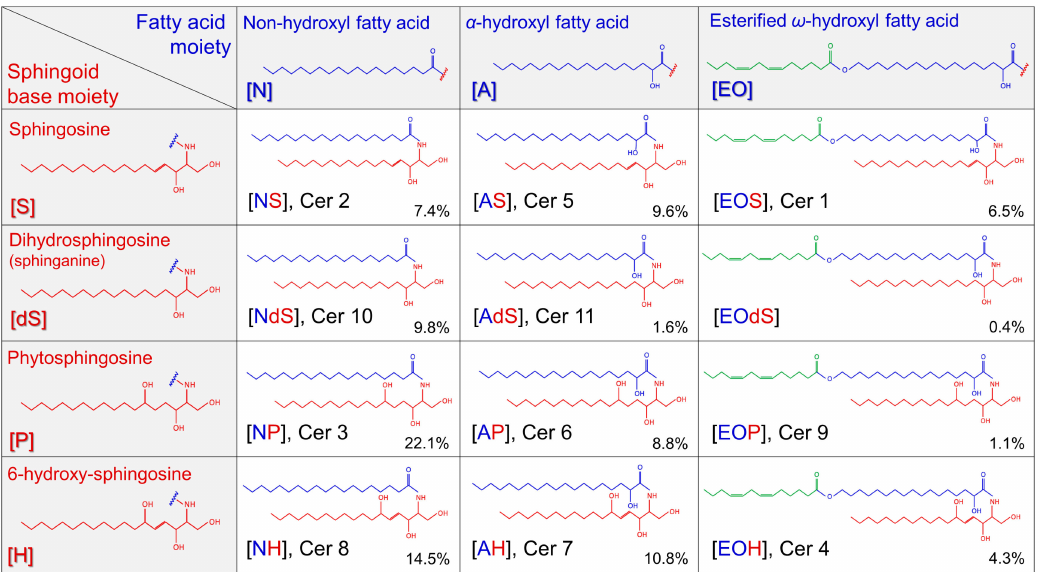
Figure 1. Main ceramide classes. The sphingoid bases consist of dihydrosphingosine (dS) (also referred to as sphinganine), sphingosine (S), phytosphingosine (P), or 6-hydroxy sphingosine (H). The fatty acid (FA) may be a non-hydroxyl with FA (N), α -hydroxyl fatty acid (A), or esterified ω -hydroxyl fatty acid (EO). In the figure next to class name, also old nomenclature for ceramides is given. In the right lower part of each ceramide class its relative amount is given as percentage of total ceramide amount